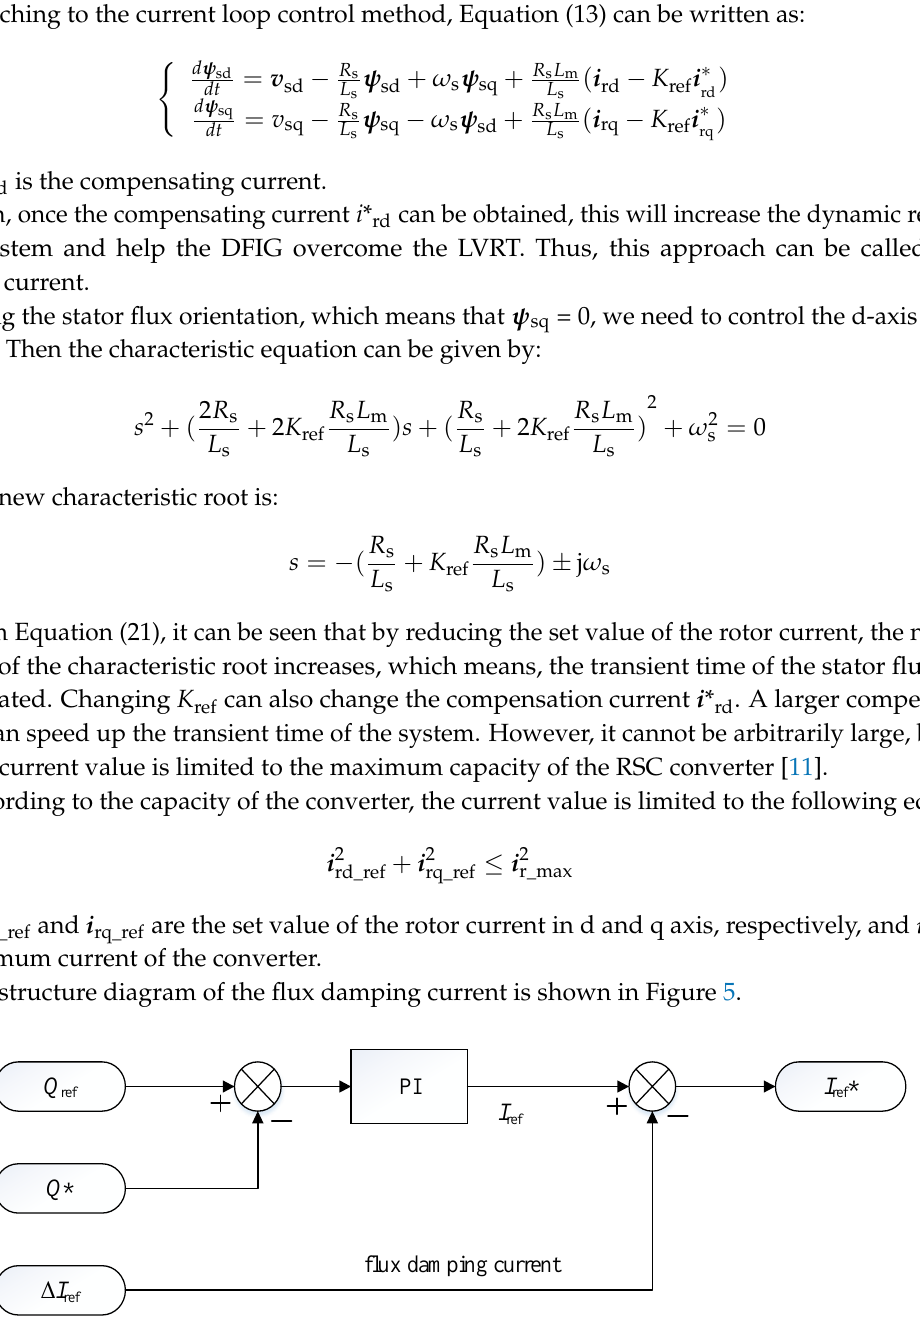
Figure 5. The schematic diagram of the flux damping current.